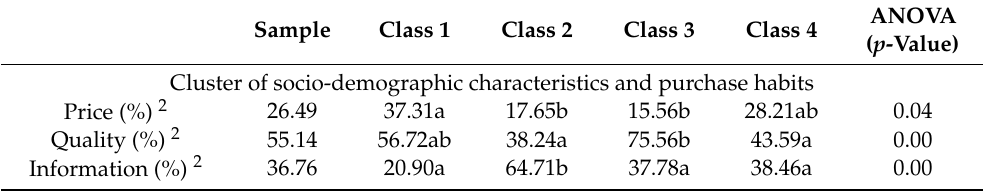
Table 6. Relative importance. Main attributes of sustainable pasta according to classes. Sample Class 1 Cluster of socio-demographic characteristics and purchase